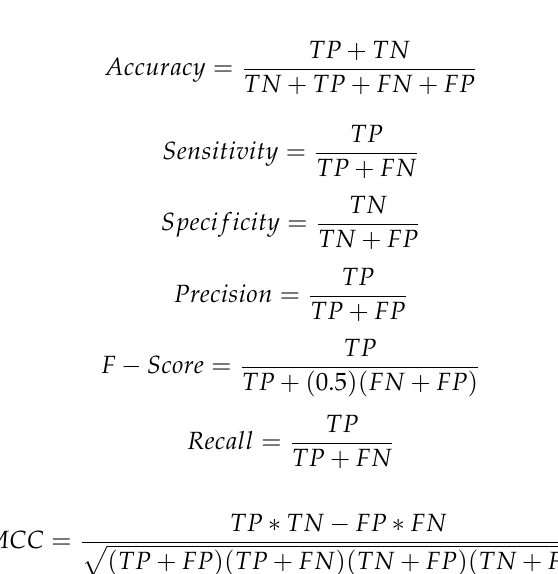
Figure 13. Comparison of ROC on the WSI